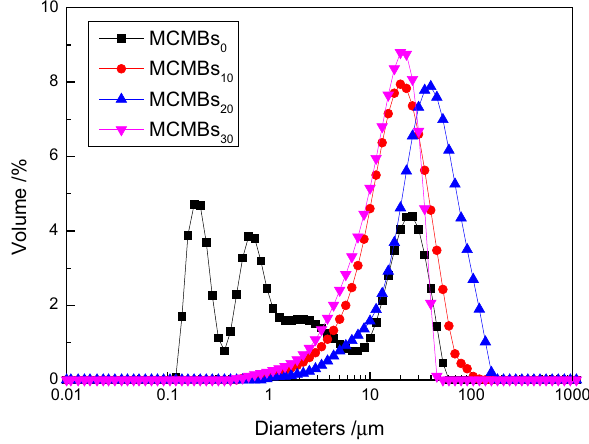
Fig. 2 Particle sizes distribution of